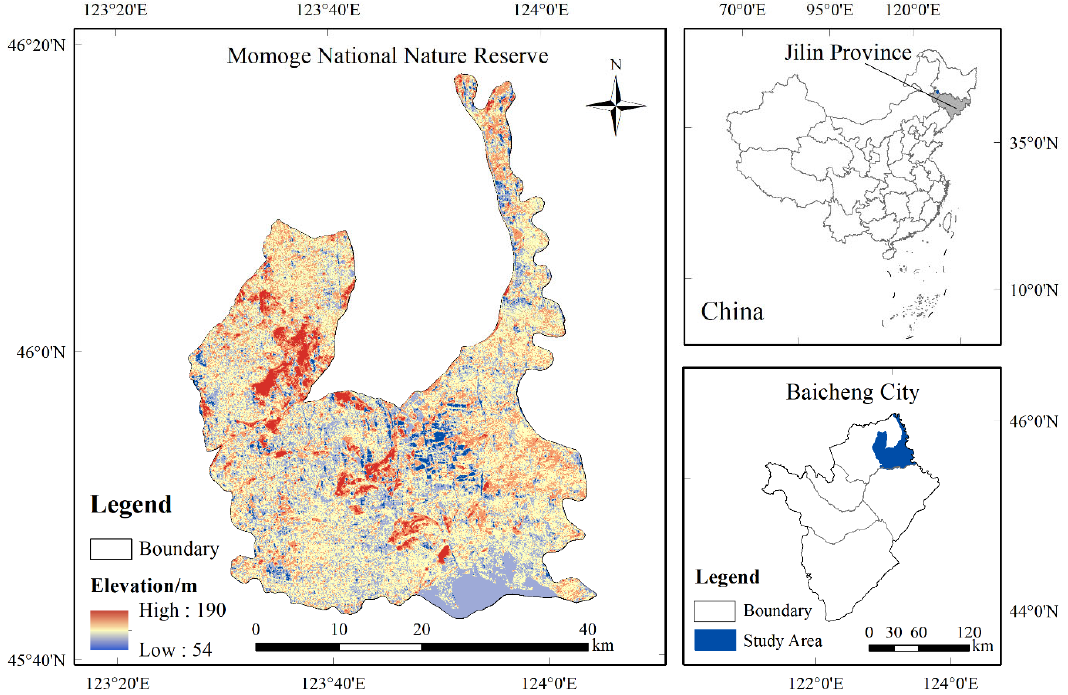
Figure 1. Location of Momoge Internationally Important